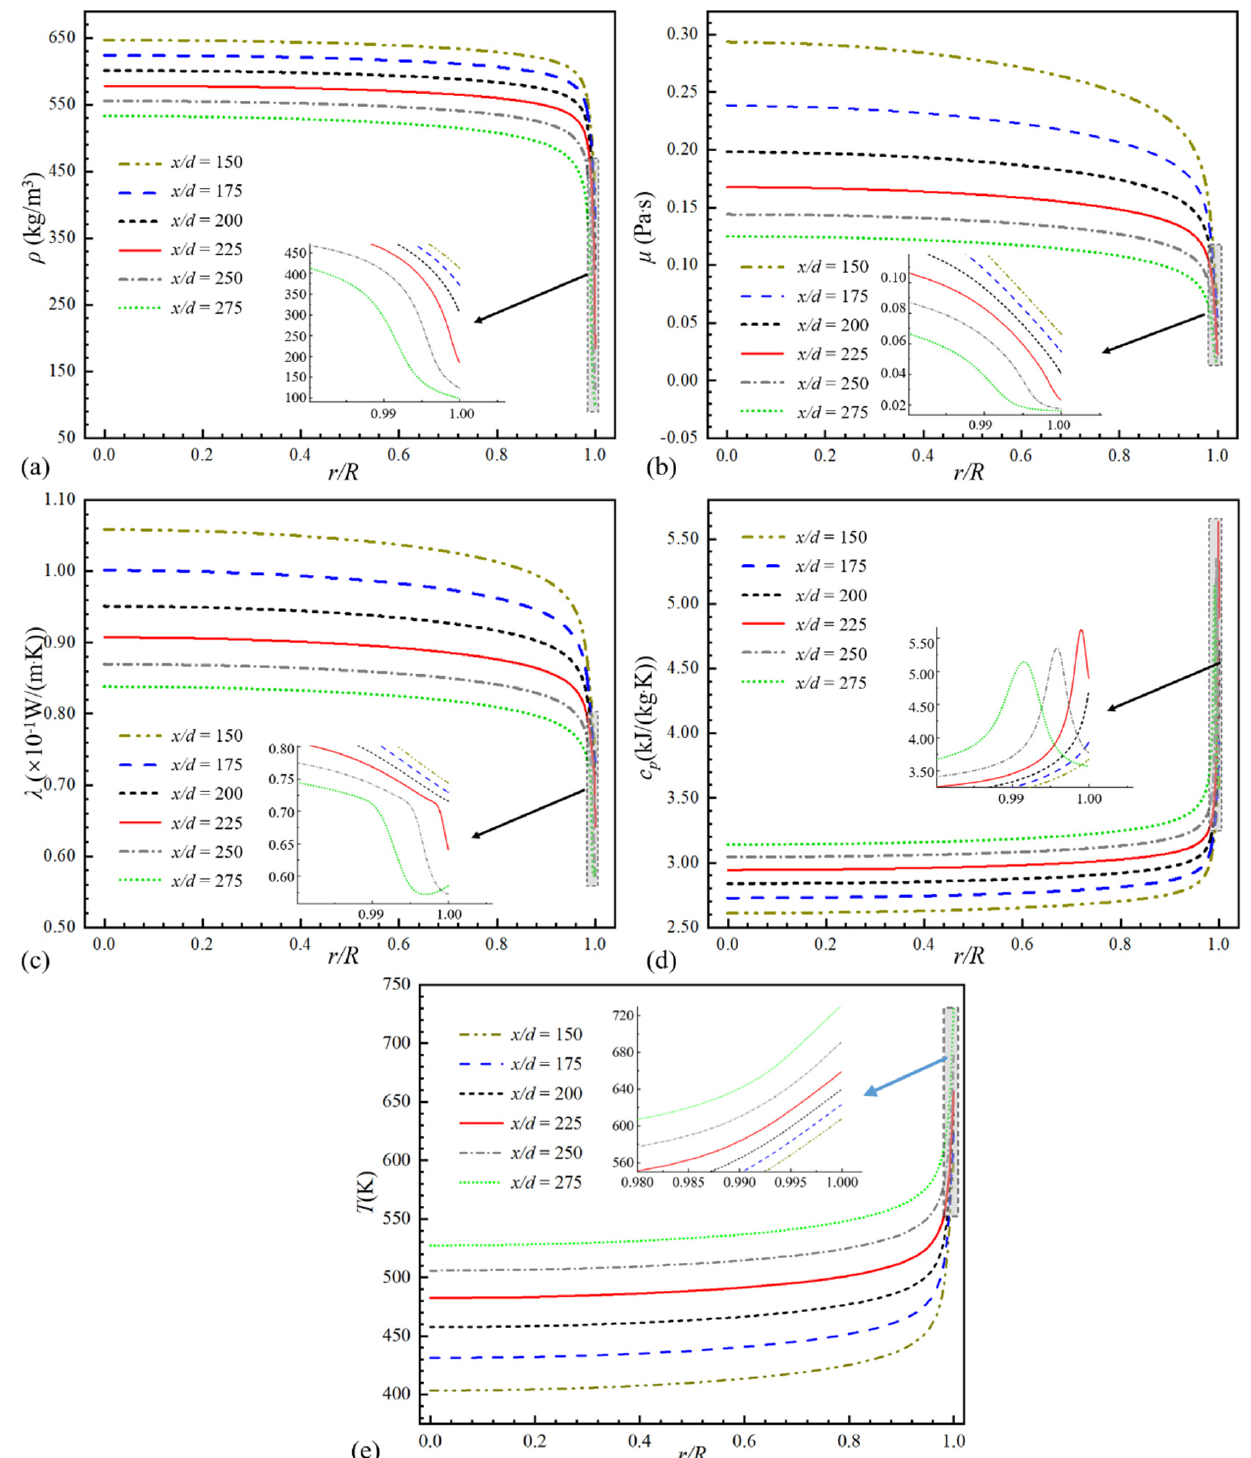
Figure 6. Radial distributions of fluid properties in first HTD zone: ( a ) density; ( b ) viscosity; ( c ) thermal conductivity; ( d ) specific heat; ( e ) fluid temperature.